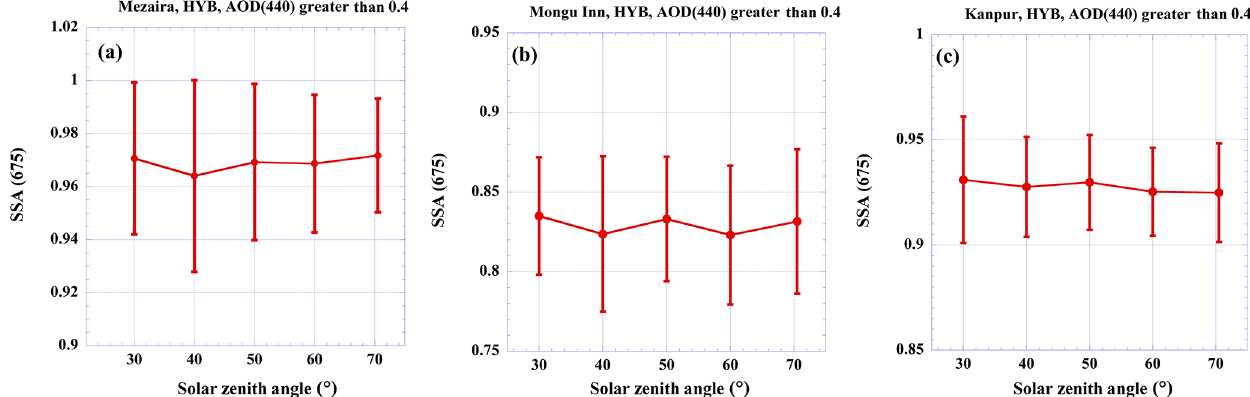
Figure 14. Dependence of 675nm SSA hybrid scan retrievals on SZA for three AERONET sites: (a) Mezaira, (b) Mongu Inn, (c) Kanpur. Table 13. Hybrid sky scan with azimuth (AZ) and view zenith angle (VZA) for three selected solar zenith angles at 30, 60, and 75 ◦ . NA – not available.